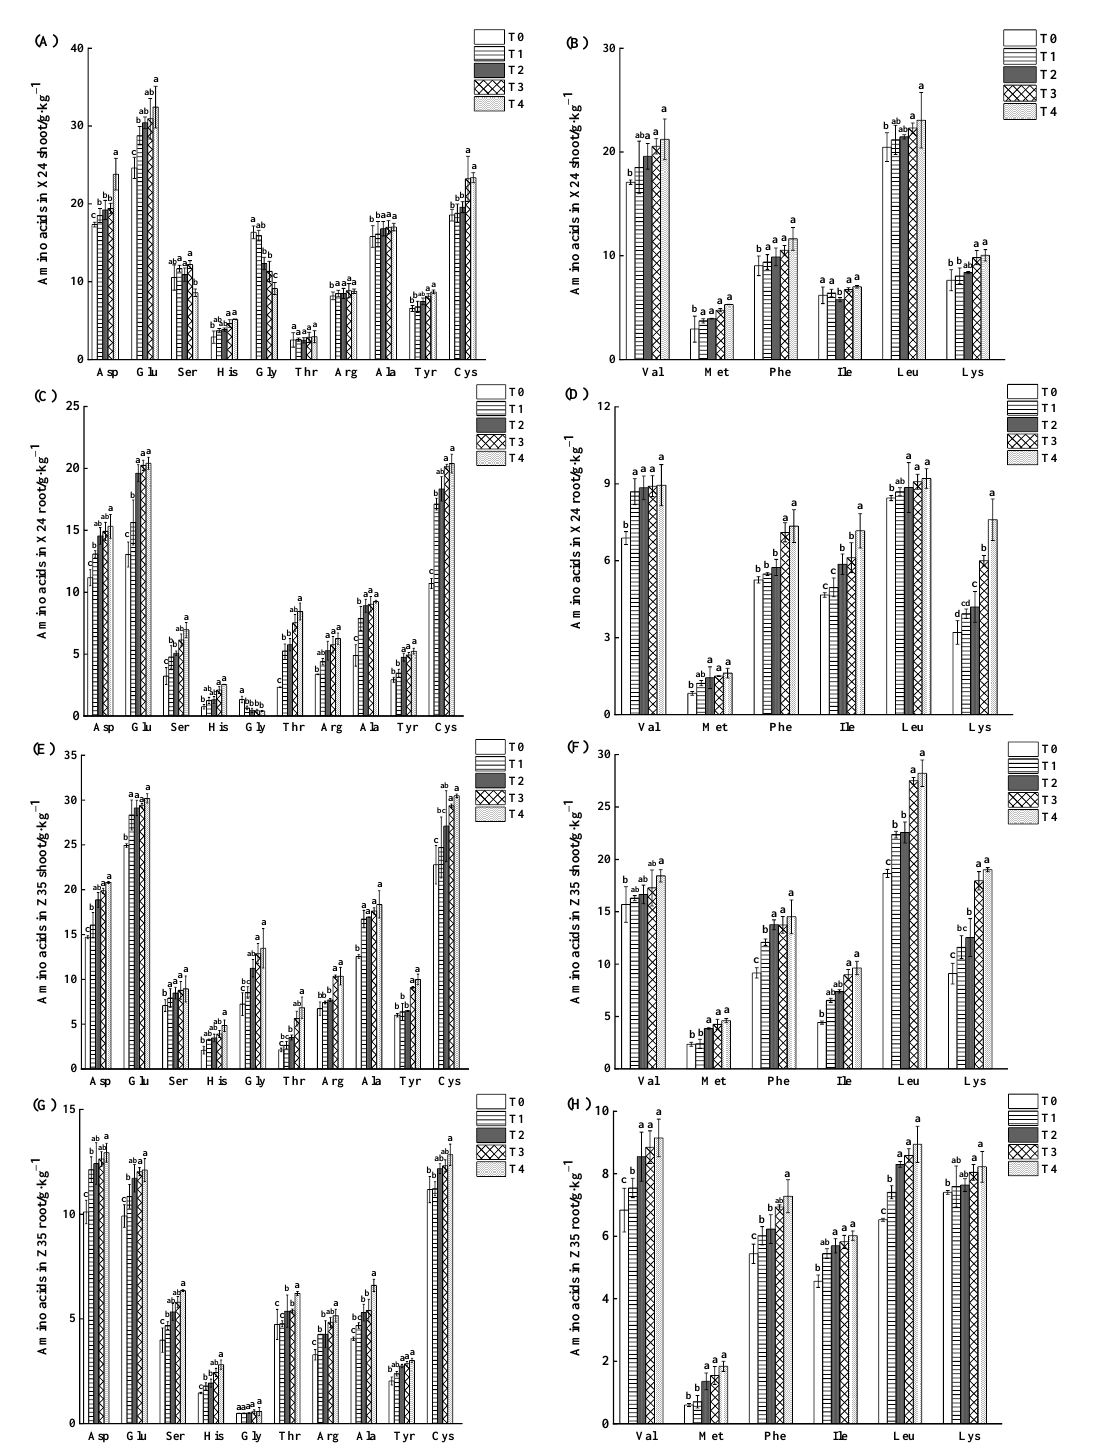
Figure 4. Effect of chlorinated amino acid on total amino acid content in shoots ( A , B , E , F ) and roots ( C , D , G , H ) of rice seedlings. T0, T1, T2, T3 and T4 respectively represent the application of 0, 0.2, 0.5, 0.8 and 1.2 mmol·L −1 chlorinated amino acetic acid treatment. Different lowercase letters indicate significant differences between treatments ( p < 0.05).